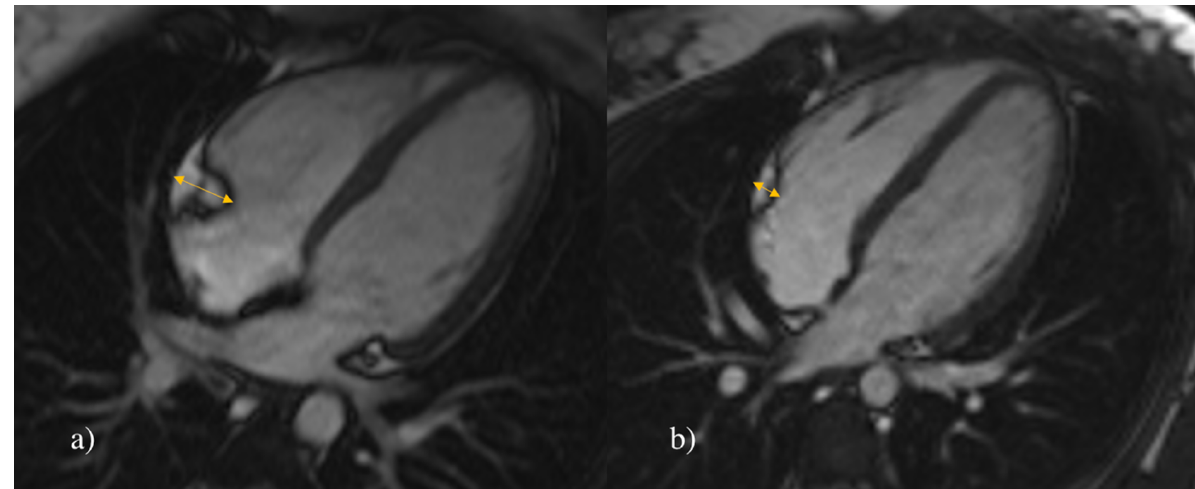
Figure 2. Measurement of EAT thickness. Representative MR four-chamber long-axis image of the heart in cine SSFP sequence in 17-year-old females. Arrows are indicating epicardial adipose (EAT) tissue thickness in right atrioventricular groove. The measured EAT thickness in ( a ) a hypertensive patient was 1.12 cm and in ( b ) a healthy control was 0.44 cm.